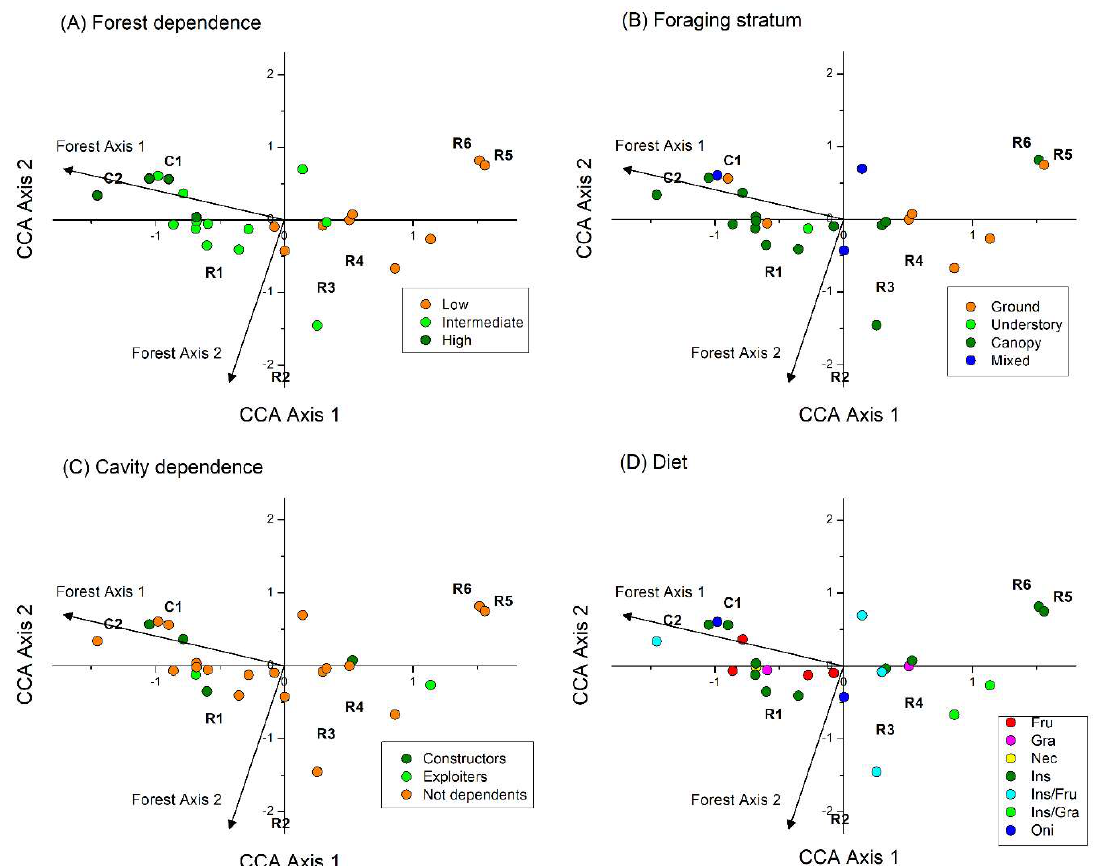
Figure 3. Distribution of the relative abundance of combined bird functional traits on reference (C1 and C2) and under restoration (R1–R6) sites in relation to riparian forest structure (Forest Axes 1 and 2) according to canonical correspondence analysis. Symbol colors represent the position of traits of different functional categories: ( A ) forest dependence, ( B ) foraging stratum, ( C ) cavity dependence for nesting, ( D ) diet.